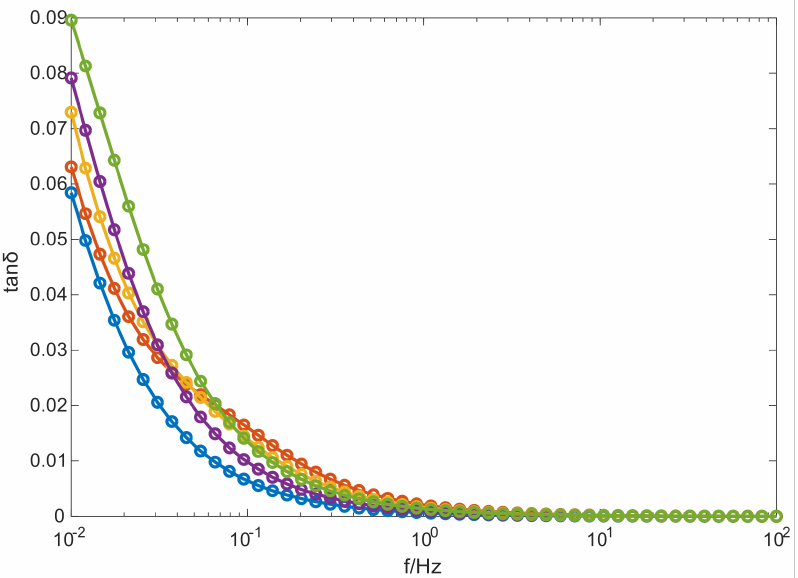
Figure 12. The frequency spectrum curves of tan δ of oil-film dielectric with different aging